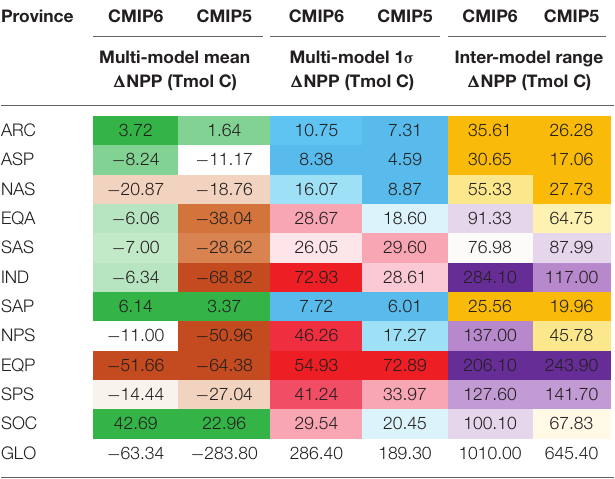
TABLE 4 | Statistics (as Tmol C changes) for the multi-model mean, 1 σ ‘likely’ range and the full inter-model range across different regions and globally for 16 CMIP6 and 10 CMIP5 models.